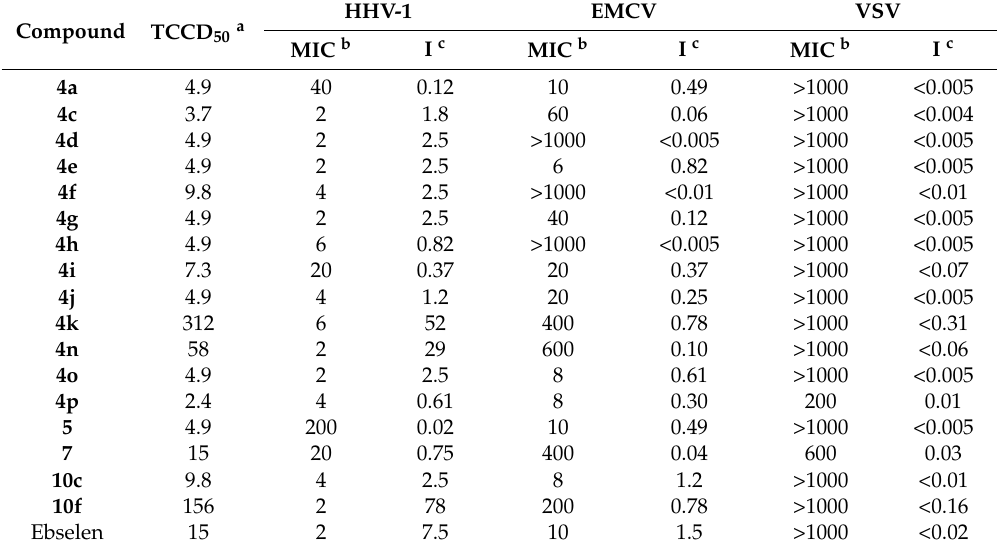
Table 4. Antiviral activity and cytotoxicity of compounds 4 , 5 , 7 , and 10